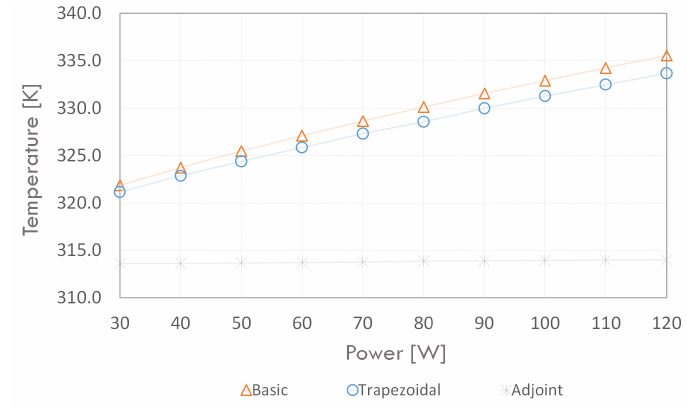
Figure 26. Temperature dependence behind the heat source versus heat